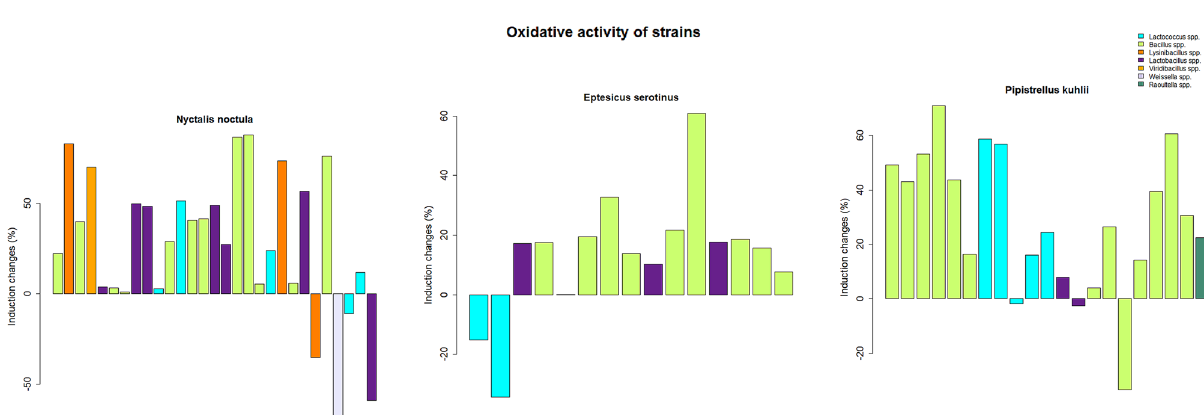
Figure 1. Pro-mutagenic and DNA-protective activity of bats guts lactic acid bacteria and bacilli measured with the E. coli RecA-biosensor. The activity was measured relative to dioxidine. The barplot legend represents groups of isolates identified by mass spectrometry.